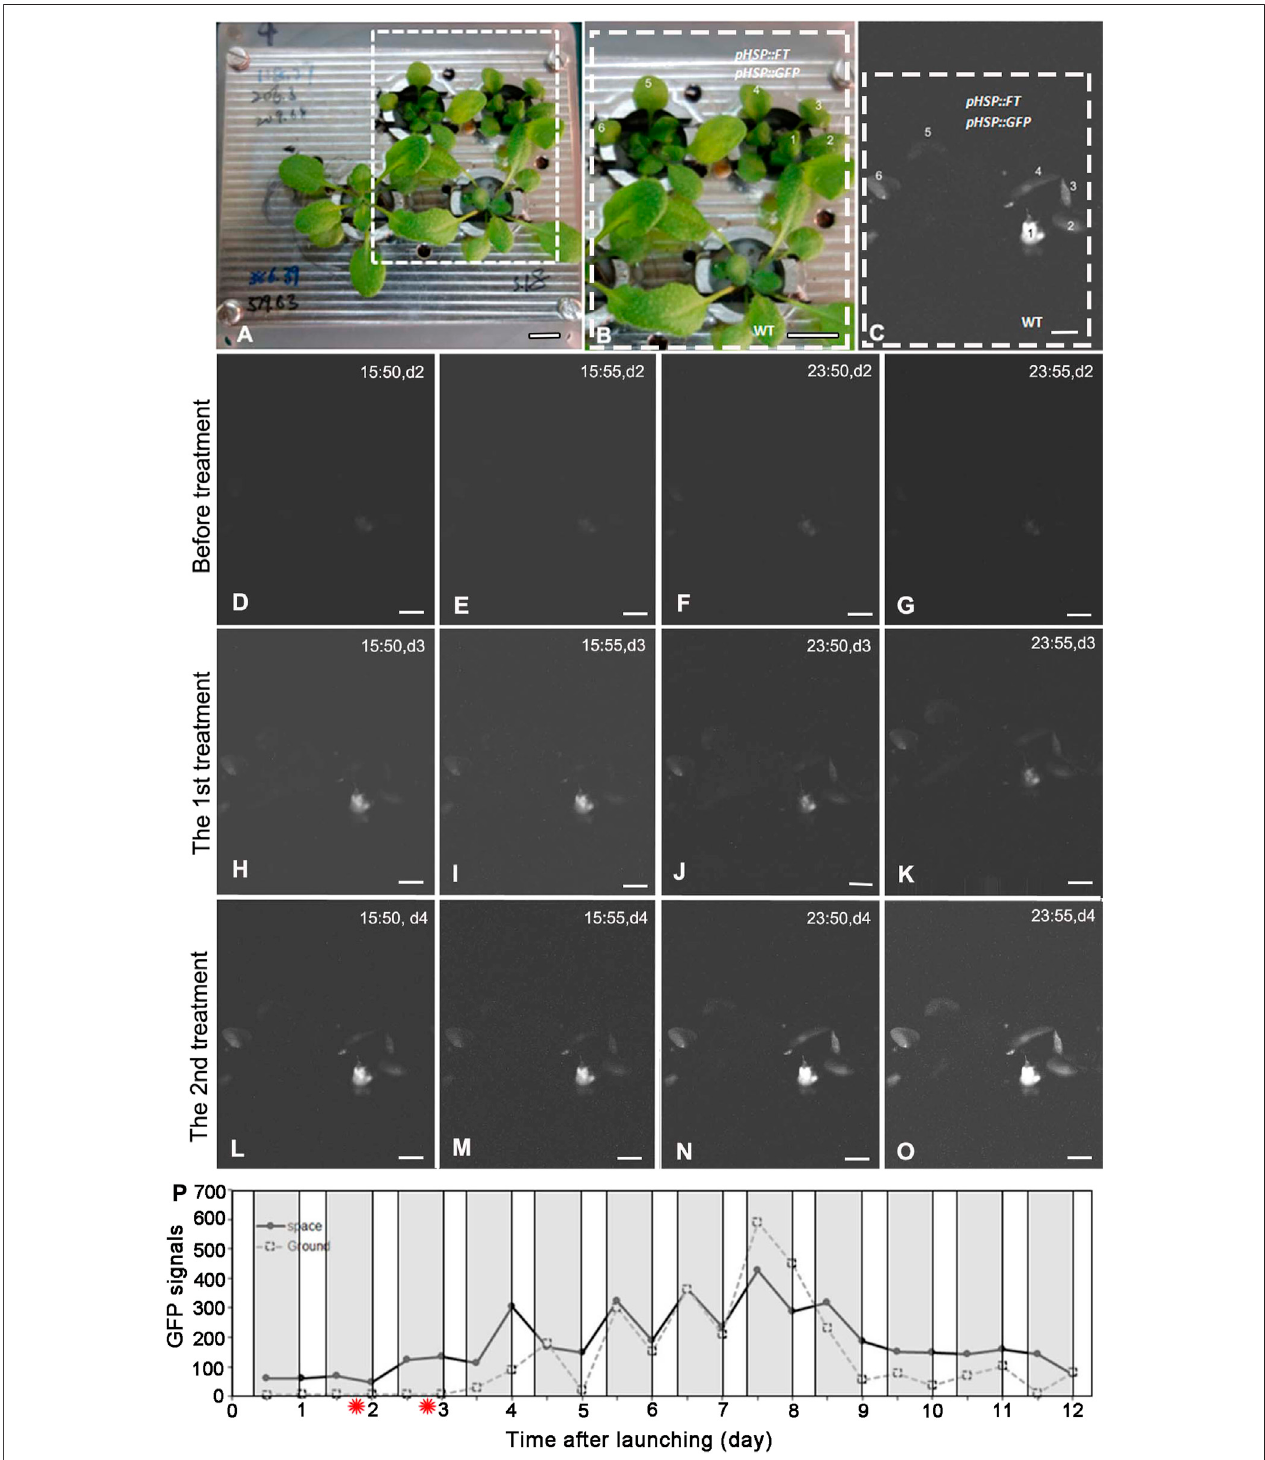
FIGURE 3 | GFP expressing in plants grown under the short-day treated by heat shock on board SJ-10. (A,B) pHSP : FT ; pHSP : GFP transgenic plants (FG) and wild-type (WT) plants photographed in white light before launching. The framed region in (A) is detailed in (B) . Bars (cid:1) 10 mm. (C) A represent GFP image showed the expression of GFP in leaves one to six of plants in (B). Bar (cid:1) 5 mm. (D – O) Example GFP images were captured by the GFP imager at day 2 to day 4 after heating treatment. The images were captured at four time points (15:50, 15:55, 23:50 and 23:55 on board SJ-10 satellite time) every day and re fl ect heating induction